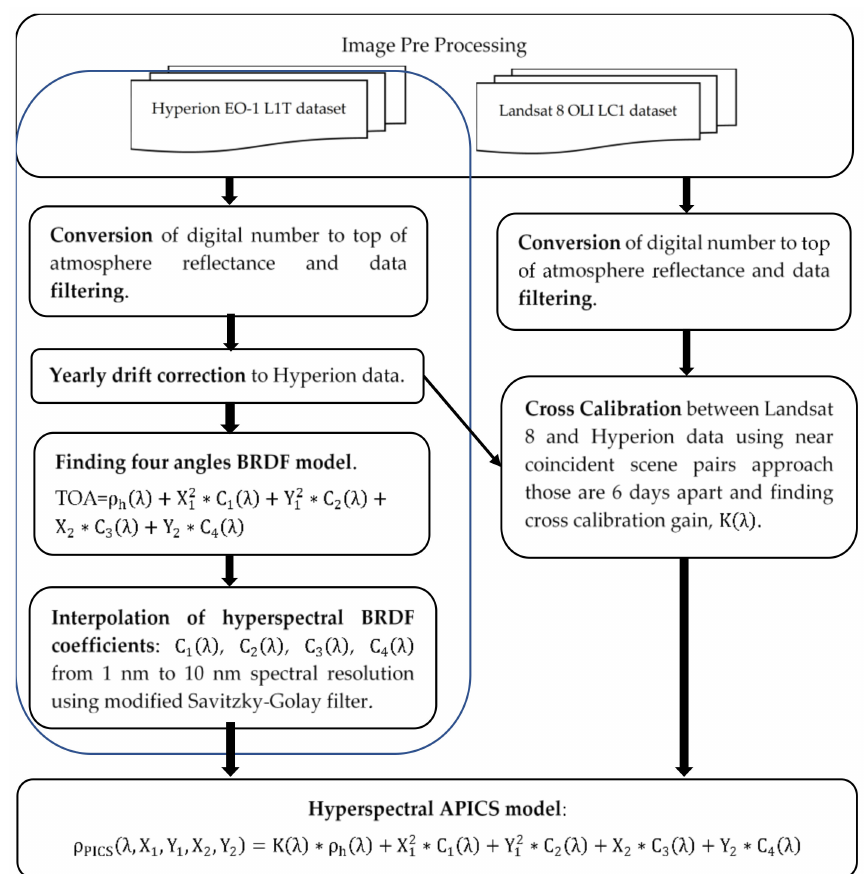
Figure 2. Flowchart of hyperspectral APICS model